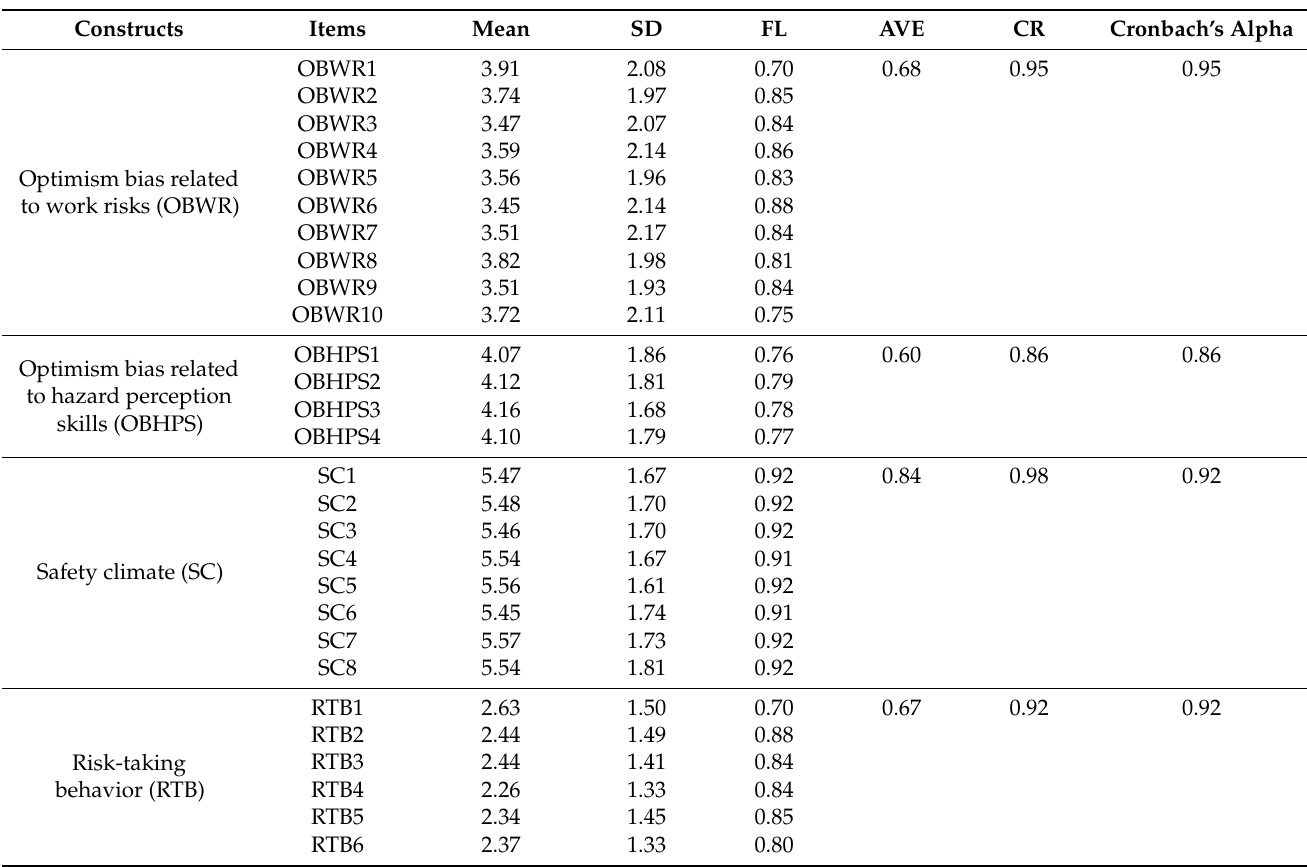
Table 4. Results of the convergent validity and reliability assessment.